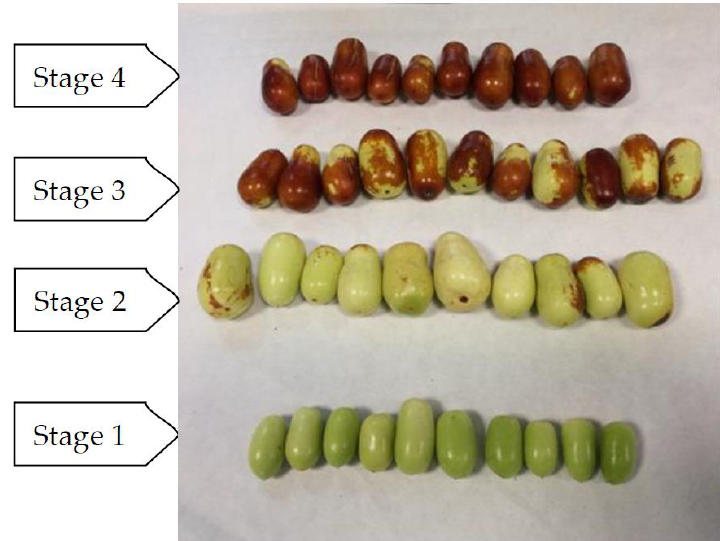
Figure 1. Different stages of maturation of jujube fruits.